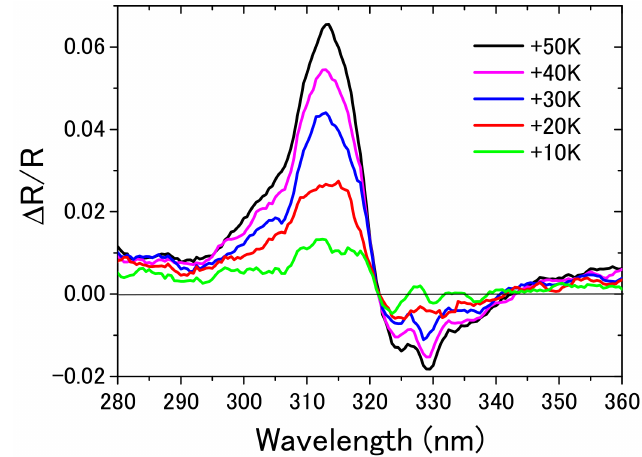
Figure 7. Temperature difference spectra normalized by the reflection spectrum at room temperature. The temperature is increased from room temperature in steps of +10